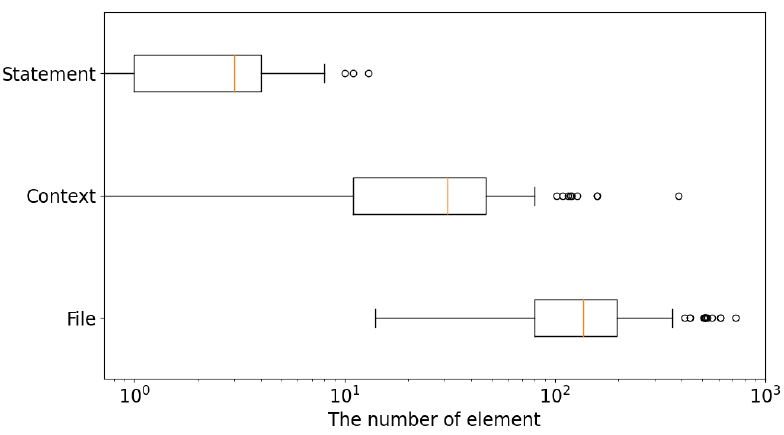
Figure 5. Distribution of